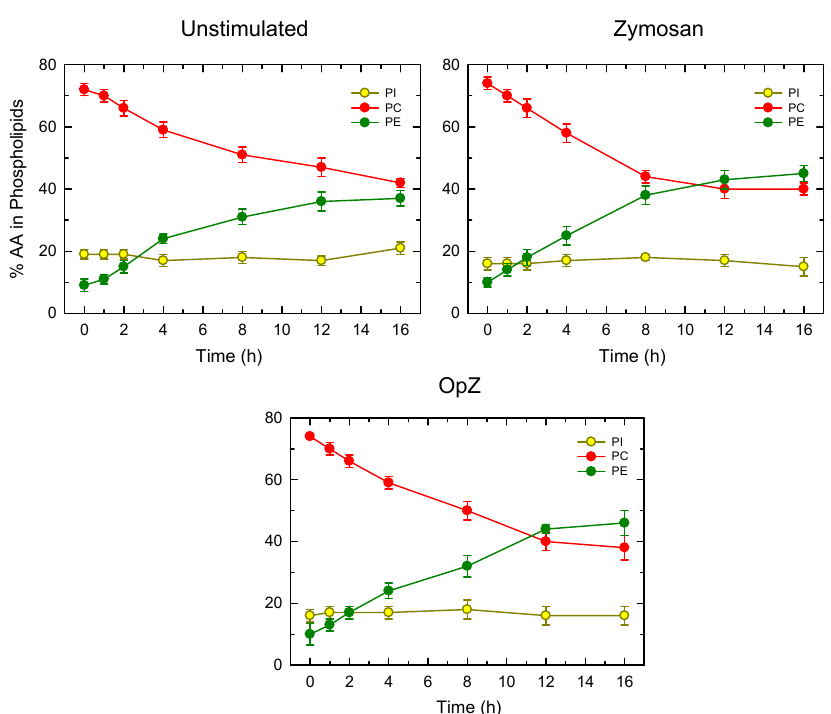
Figure 7. Phospholipid AA remodeling in peritoneal macrophages and the e ff ect of cellular stimulation. The cells were pulse-labeled with [ 3 H]AA, washed, and incubated without label for the indicated periods of time in the absence (unstimulated; left panel) or presence of 1 mg / mL zymosan (middle panel) or 1 mg / mL OpZ (right panel). Phospholipid classes were separated by thin-layer chromatography. The radioactivity incorporated into each phospholipid class was determined by scintillation counting and is given as a percentage of the total radioactivity present in phospholipids. Results are shown as means ± S.E.M. ( n = 6).